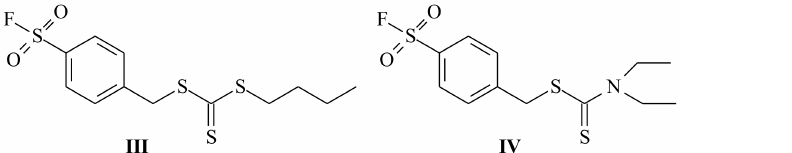
Figure 3. The structures of 4-(fluorosulfonyl)benzyl butyl trithiocarbonate ( III ) and 4-(fluorosulfonyl) benzyl diethylcarbamodithioate ( IV